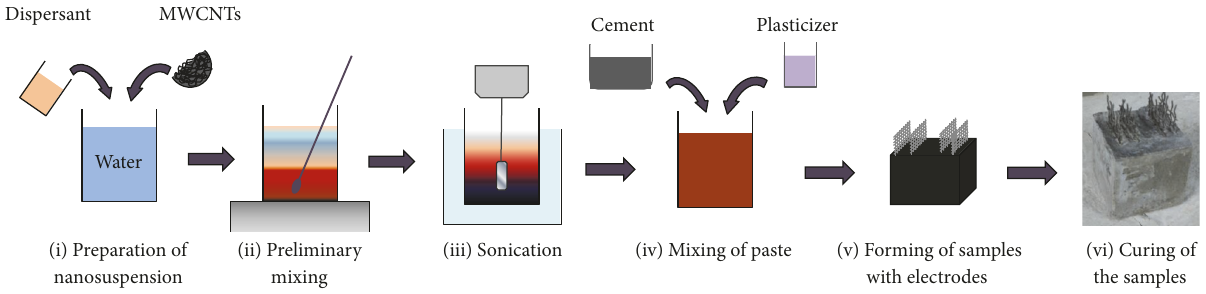
Figure 2: Preparation process of the cement paste samples with 1% of